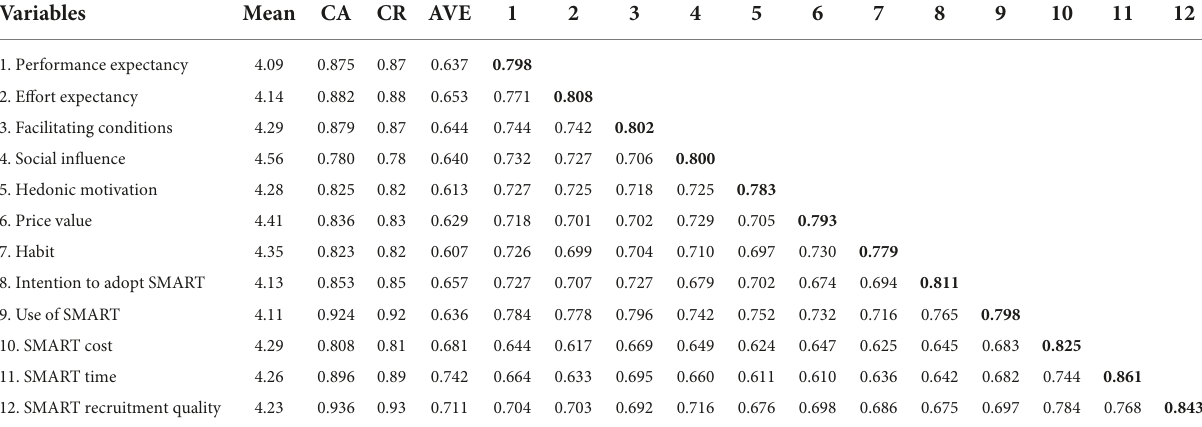
TABLE 3 Inter-correlation matrix, reliability of constructs, composite reliability, and average variance extracted.